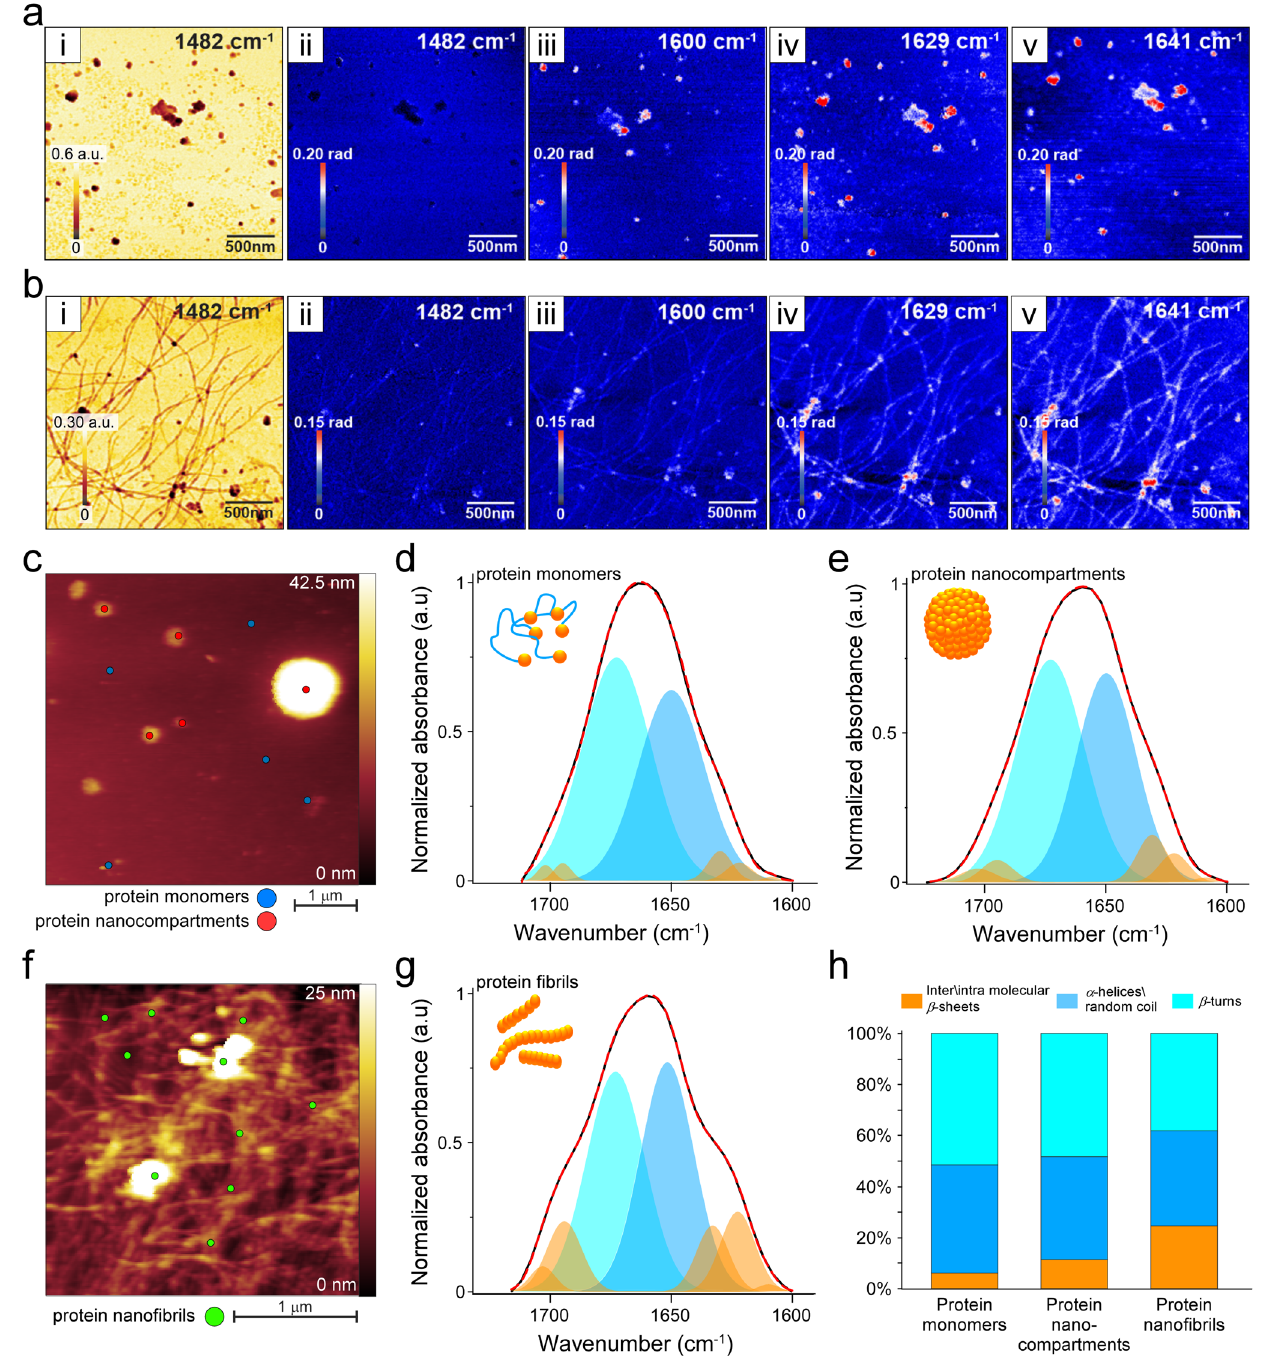
Fig. 3 | Nano-FTIR analysis of silk protein assemblies. FTIR maps collected from samples containing a a mixture of protein nanocompartments and protein monomers and b silk protein nano fi brils. (i) FTIR- re fl ection maps collected at 1482cm − 1 , to distinguish general protein content from organic contaminants (negativecontrol);(ii)absorptionmapscollectedat1482cm − 1 ;(iii)absorptionmaps collected at 1600 cm − 1 ; (iv) absorption maps collected at 1629cm − 1 showing the β - sheet content; (v) FTIR absorption maps collected at 1641cm − 1 showing a signal from a disordered random coil and an α -helix. c AFM topography image of silk